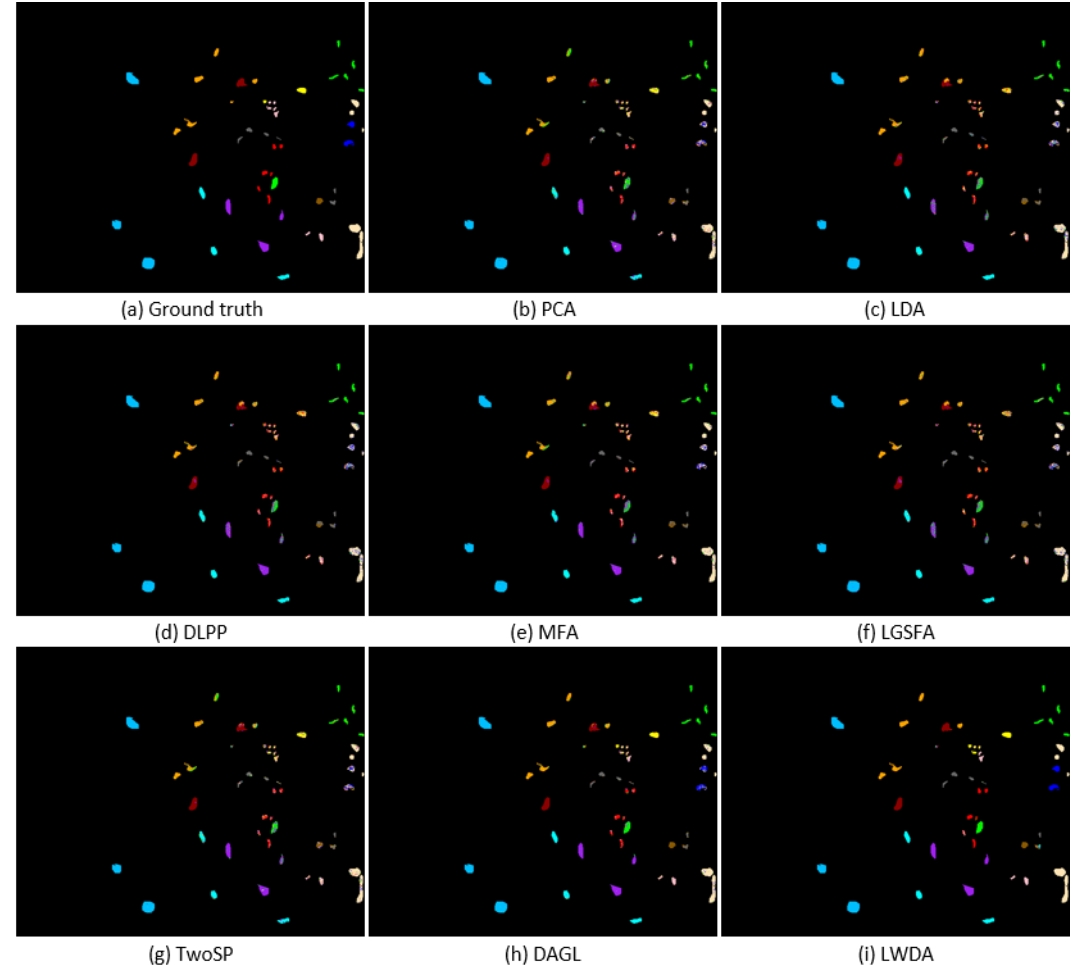
Figure 4. Classification maps of different dimensionality reduction methods with NN classifier on the KSC dataset ( τ = 0.05). ( a ) Ground truth; ( b ) PCA; ( c ) LDA; ( d ) DLPP; ( e ) MFA; ( f ) LGSFA; ( g ) TwoSP; ( h ) DAGL; ( i ) proposed LWDA.